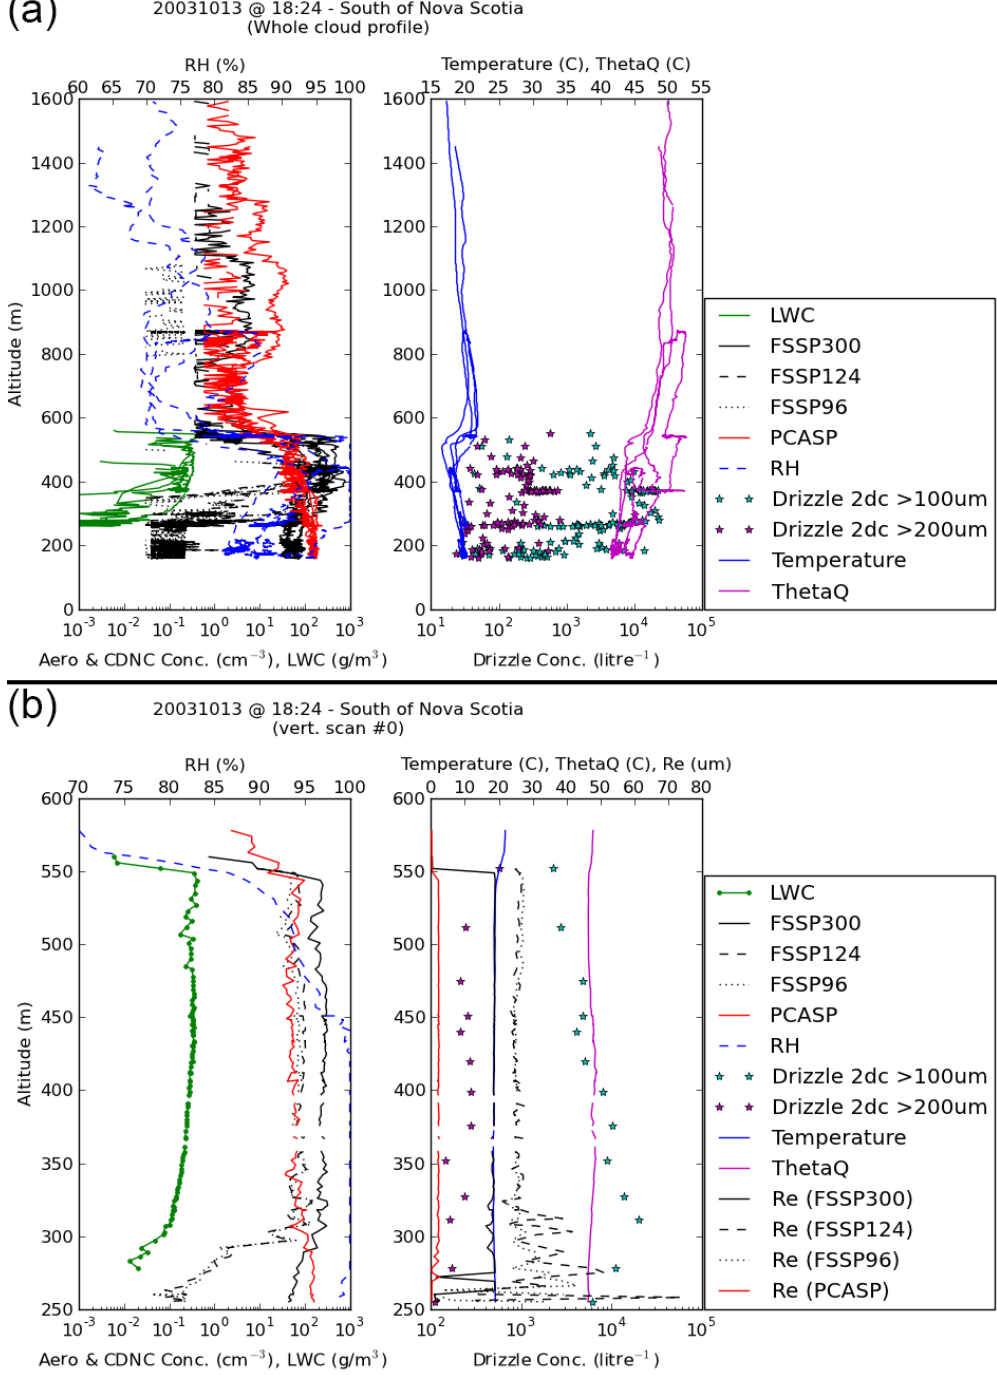
Figure 5. Two functions that display the vertical profile of a cloud. In this cloud instance, the aircraft made three vertical profiles (in addition to two below-cloud manoeuvres, two above-cloud manoeuvres and one in-cloud horizontal manoeuvre). Panel (a) was created using the function wholeprof and displays the liquid water content, FSSP total concentrations, PCASP total concentration, relative humidity, drizzle concentrations above 100 and 200 microns, as well as temperature and theta Q for all the manoeuvres as a function of altitude on the y axis. Panel (b) was created using the function vprof and displays the same quantities as (a) as well as the effective radii of the FSSP and PCASP for the first vertical profile only, as a function of altitude on the y